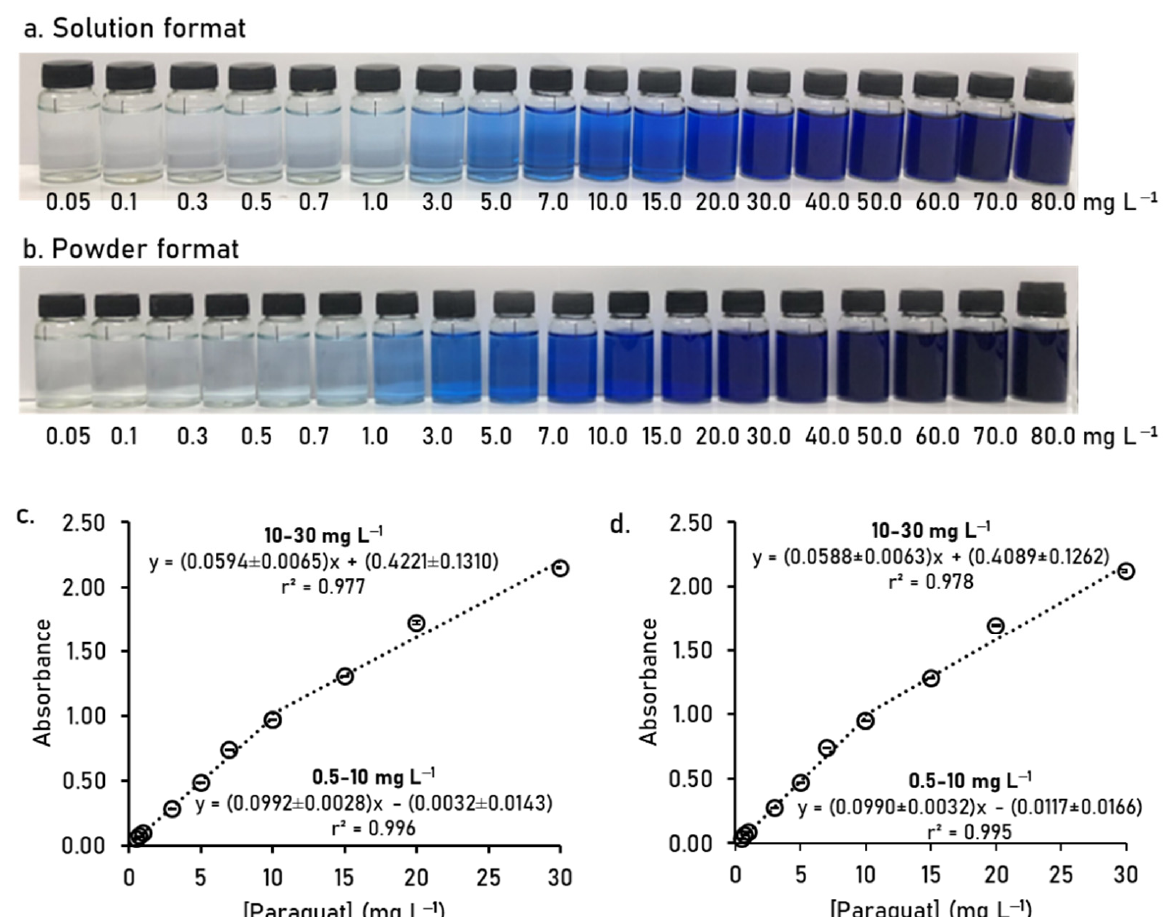
Figure 8. Naked-eye observation of paraquat free-radical ion by using sodium dithionite with ( a ) solution format and ( b ) powder format in concentration range of 0.05–80.0 mg L − 1 standard paraquats with calibration plots for ( c ) solution format and ( d ) powder format of sodium dithionite. Table 1. Analytical performance of the test kit for paraquat determination. Analytical